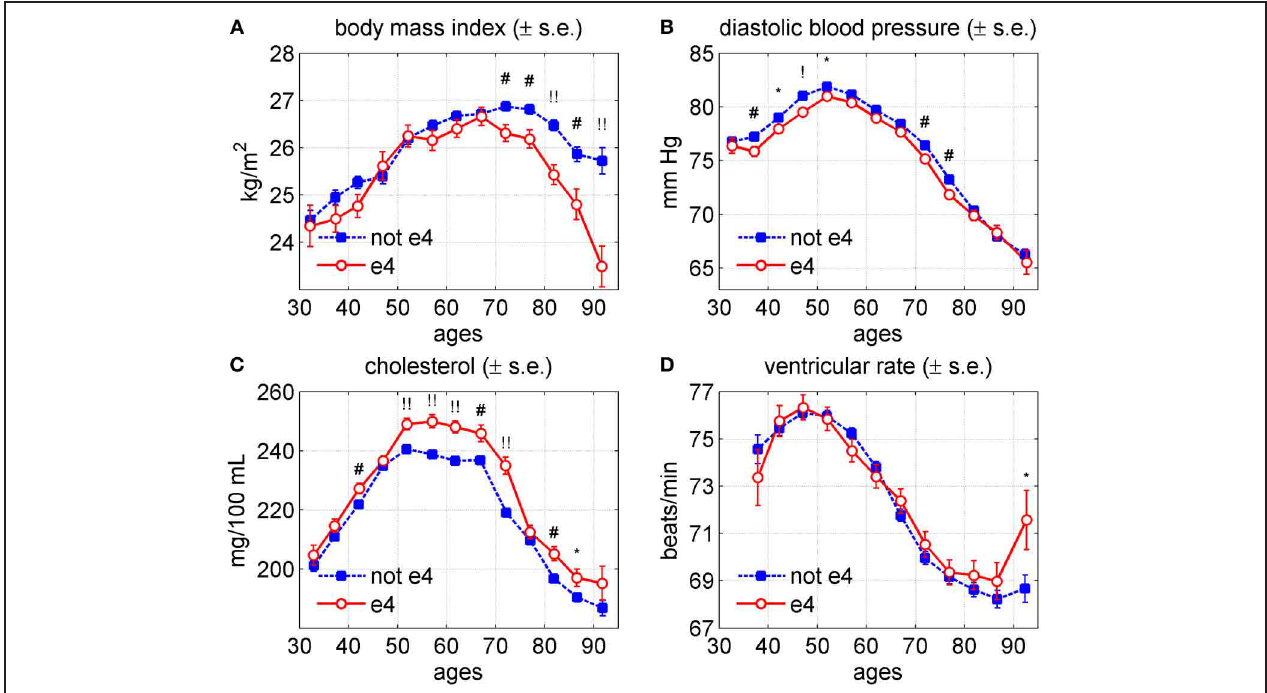
FIGURE 7 | Average trajectories ( ± standard errors) of four physiological variables for carriers (“e4”) and non-carriers (“not e4”) of the APOE e4 allele in the Framingham Heart Study (original cohort, pooled data from exams 1–28). (A) Body mass index; (B) diastolic blood pressure;